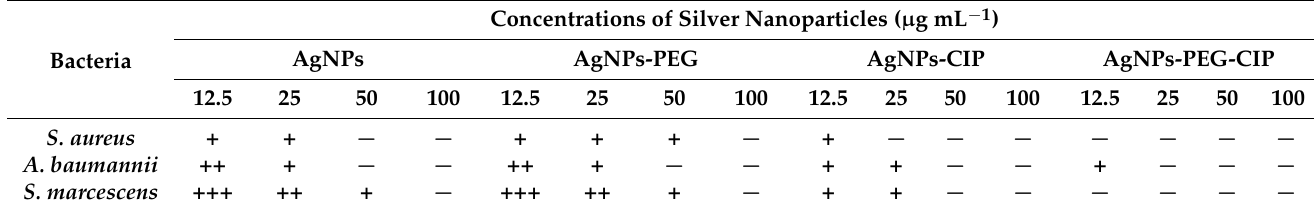
Table 2. Effect of AgNPs and their conjugates on the biofilm produced by the tested bacteria.